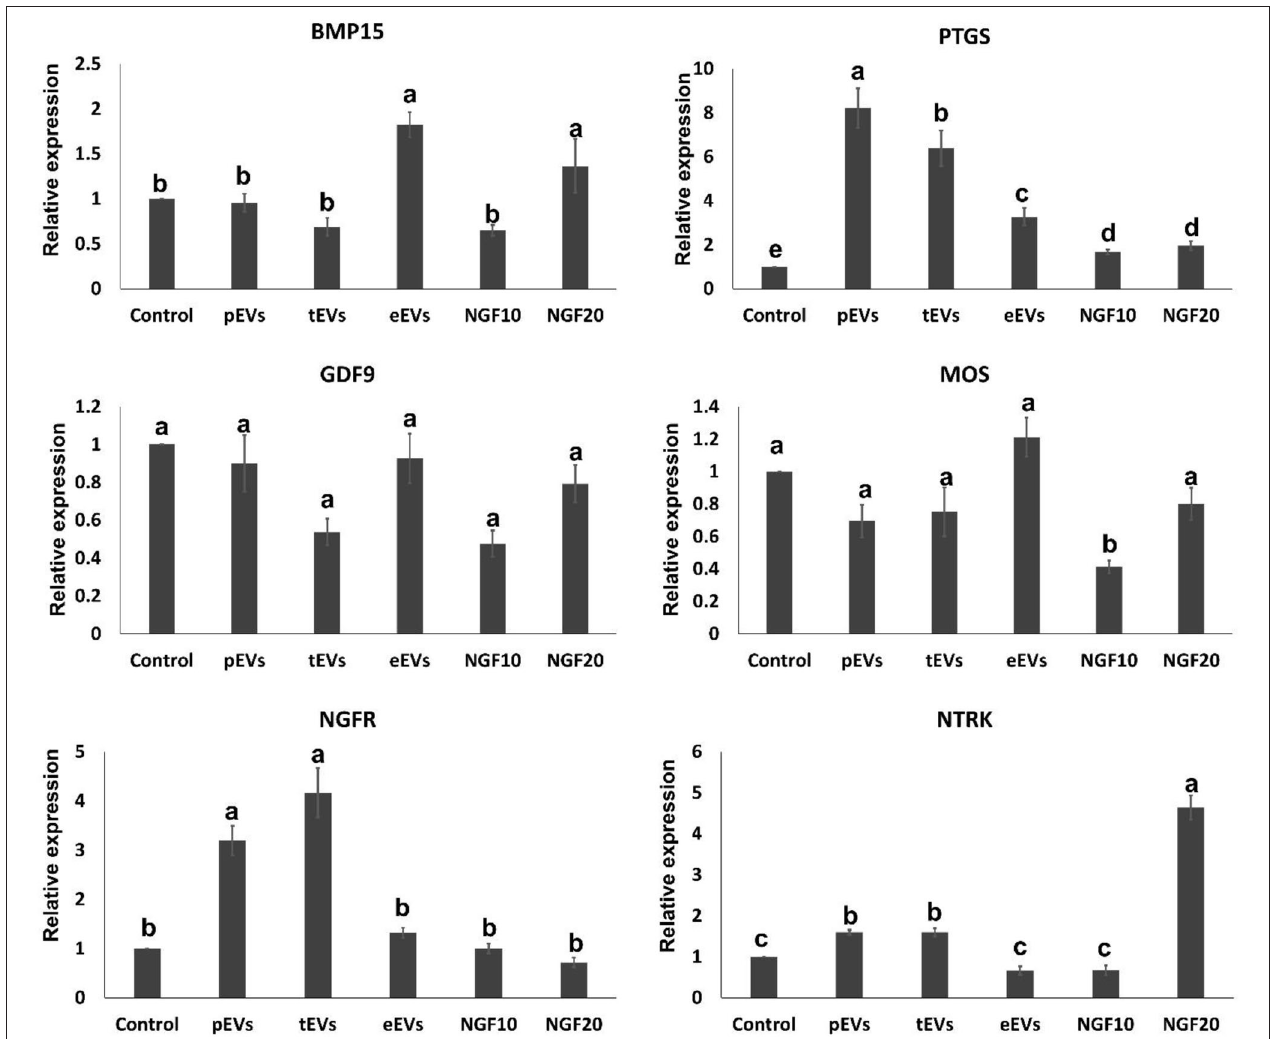
FIGURE 8 | Effects of the prostate, testis, and epididymis extracellular vesicles (EVs) on oocyte gene expression compared to different doses of nerve growth factor (NGF). Different letters ( a – c ) indicate significant difference at p <